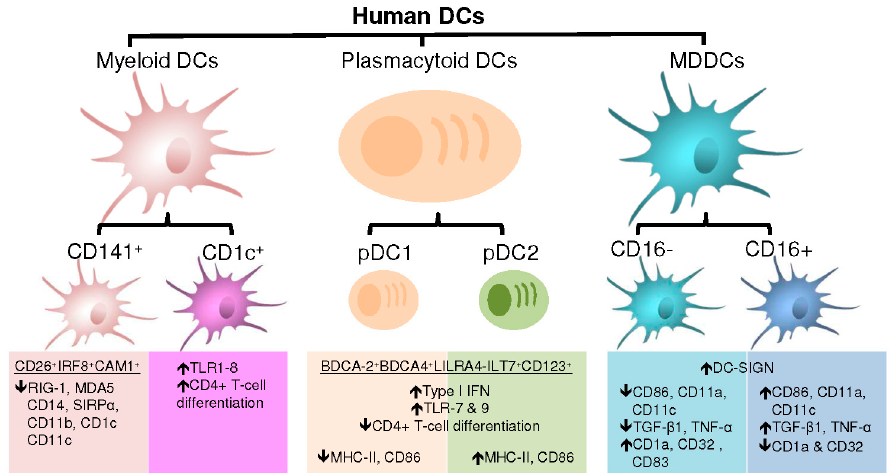
Figure 2. Human DC are divided into three major subsets: plasmacytoid DC (pDC), myeloid DC (mDC) and monocyte-derived DC (MDDC).